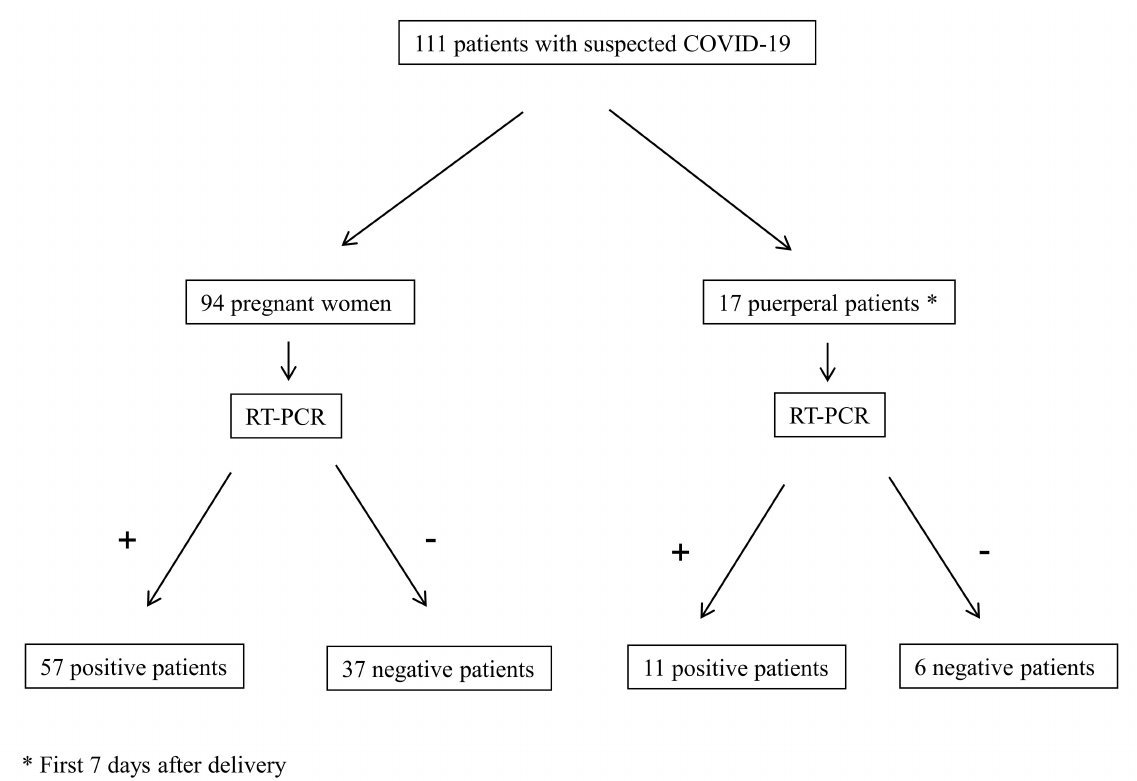
Figure 1. Flowchart of the patients included. COVID-19: coronavirus disease 2019, RT-PCR: reverse transcription polymerase chain